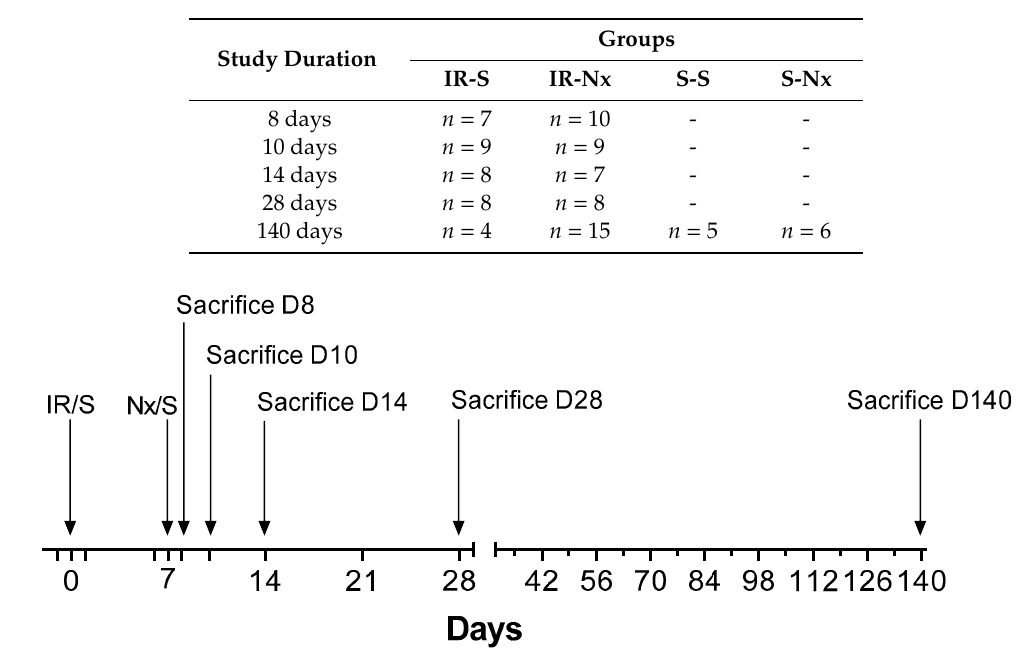
Table 1. Number of animals involved in the studies performed. IR: ischemia / reperfusion, S: sham and N x : nephrectomy.